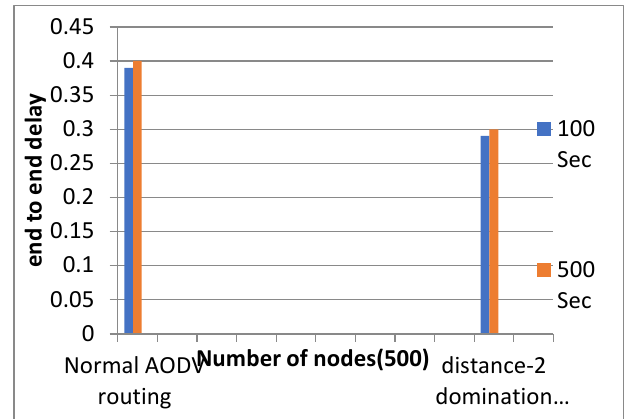
Figure. 8 Comparison of end to end delay for 500